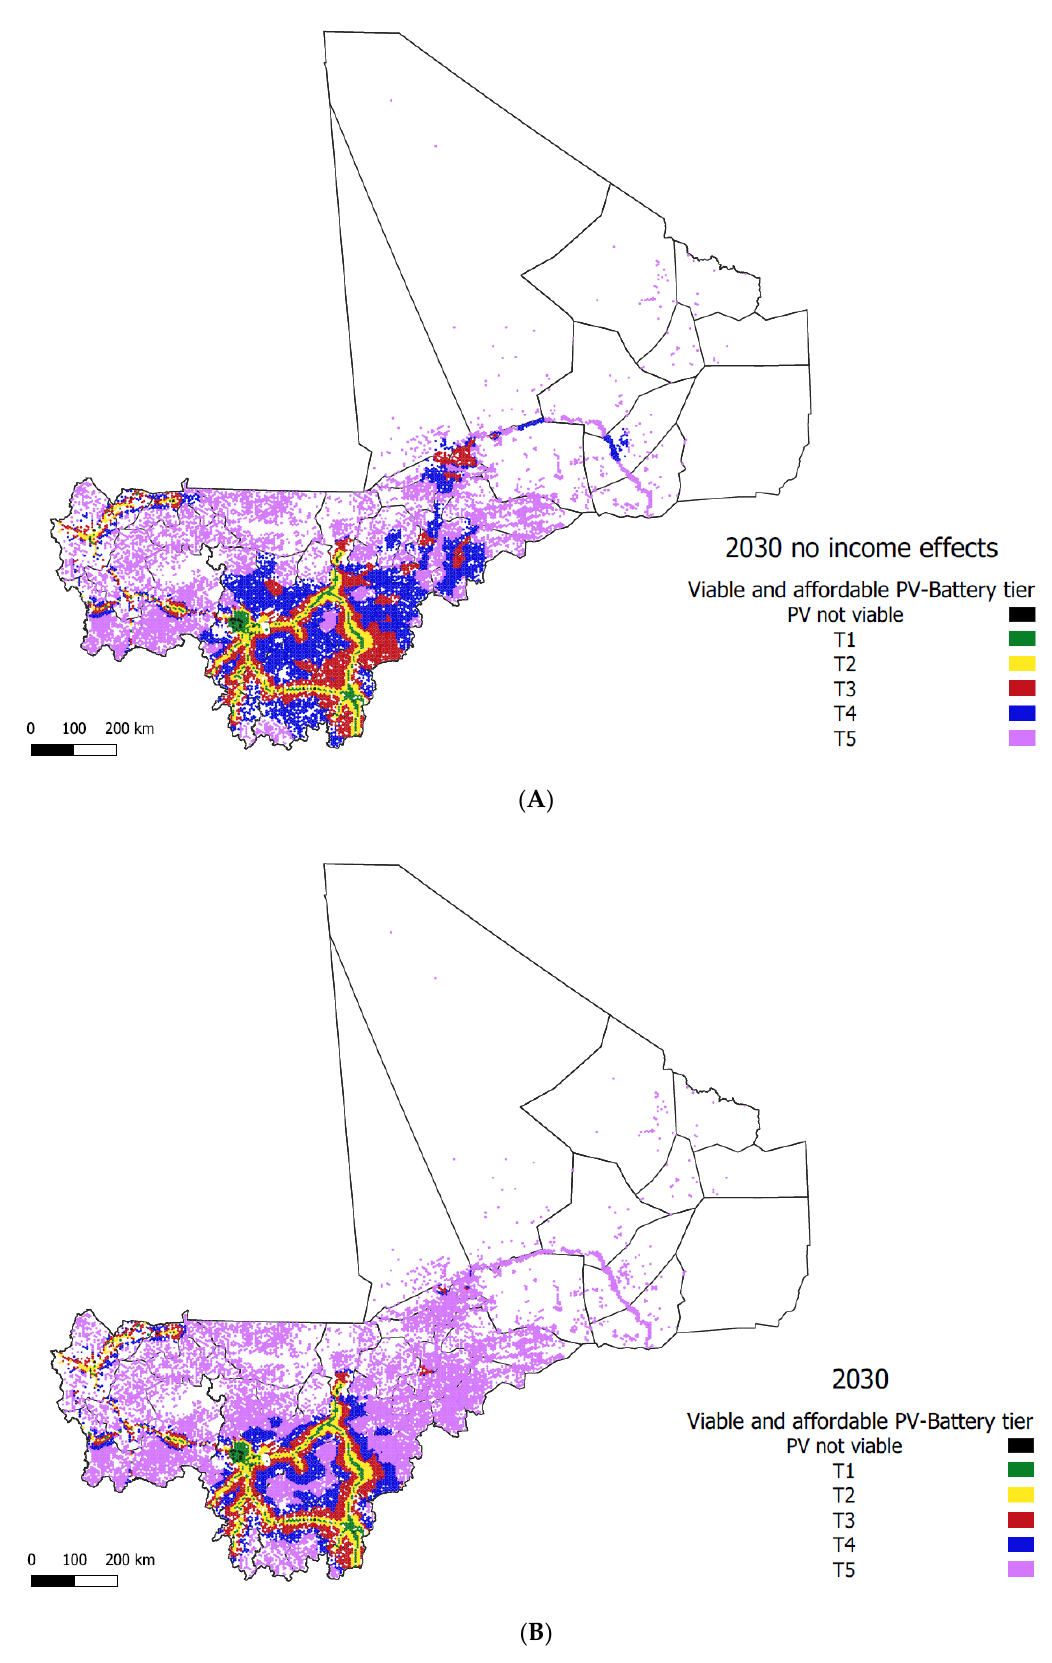
Figure 8. Viable and affordable electrification tier of the geographical units for the assumptions valid for 2030. ( A ) Without the influence of electricity consumption on income. ( B ) Influences of electricity consumption on income are considered.